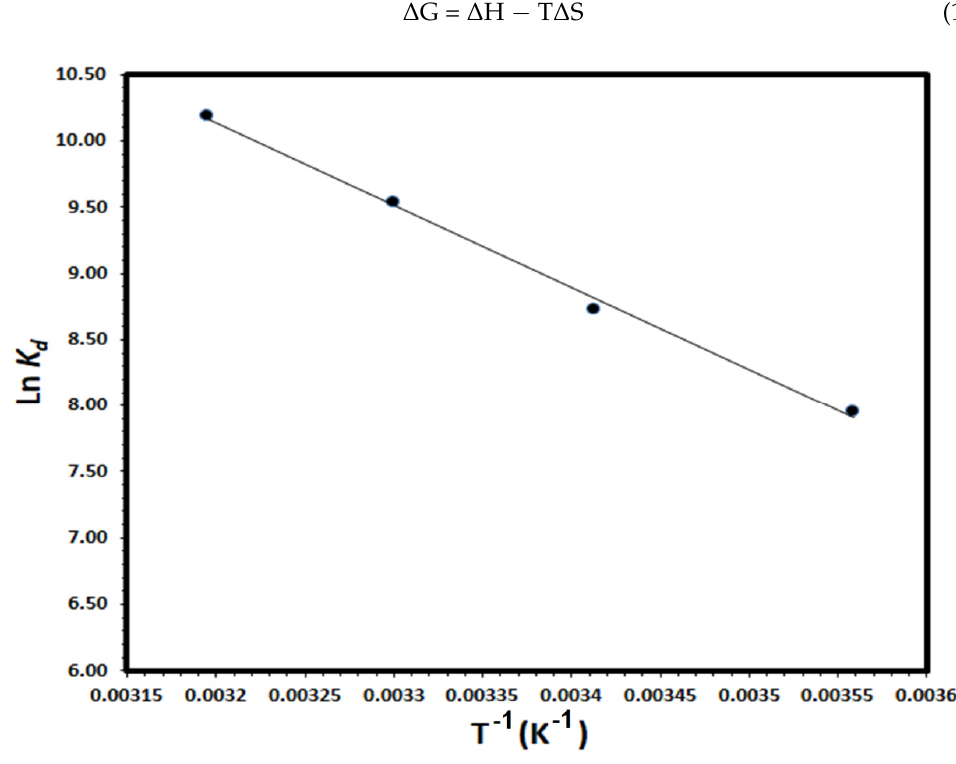
Figure 14. Plot of ln K d vs. T − 1 for the thermodynamic parameters calculations for DV31 adsorption from an aqueous solution by G CuO NPs. (Experimental conditions: DV31 concentration 25 mg/L; 0.5 mL H 2 O 2 ; sample volume 100 mL; 10.0 mg CuO NPs; 10 min contact time and pH 8.6). Thermodynamic parameters for the adsorption/removal of DV31 molecules de ‐ graded by CuO NPs were calculated and ∆ H, ∆ S and ∆ G values were +51.64 kJ/mole, +249.5 J/mole.K and − 22.71 kJ/mole, respectively. The positive value of the enthalpy